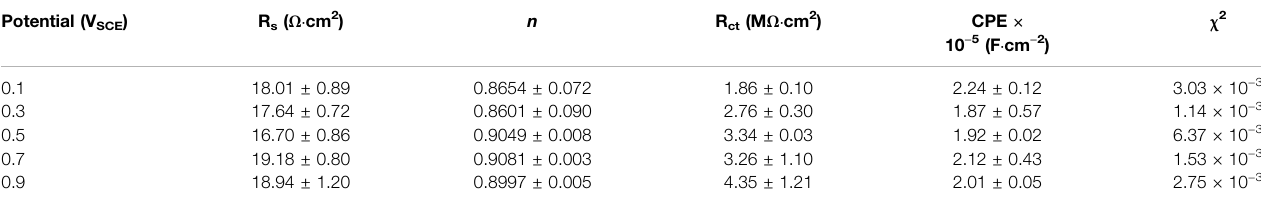
TABLE1| Fittingresultsofelectrochemicalimpedancespectraforas-castTi – 6Al – 4VafterOCPtestsinHank ’ ssolutionsat37 ° C. R charge transfer resistance, CPE describes charge transfer capacitance, n is the exponent of CPE, and χ 2 is the sum of the square of the difference between theoretical and experimental points.